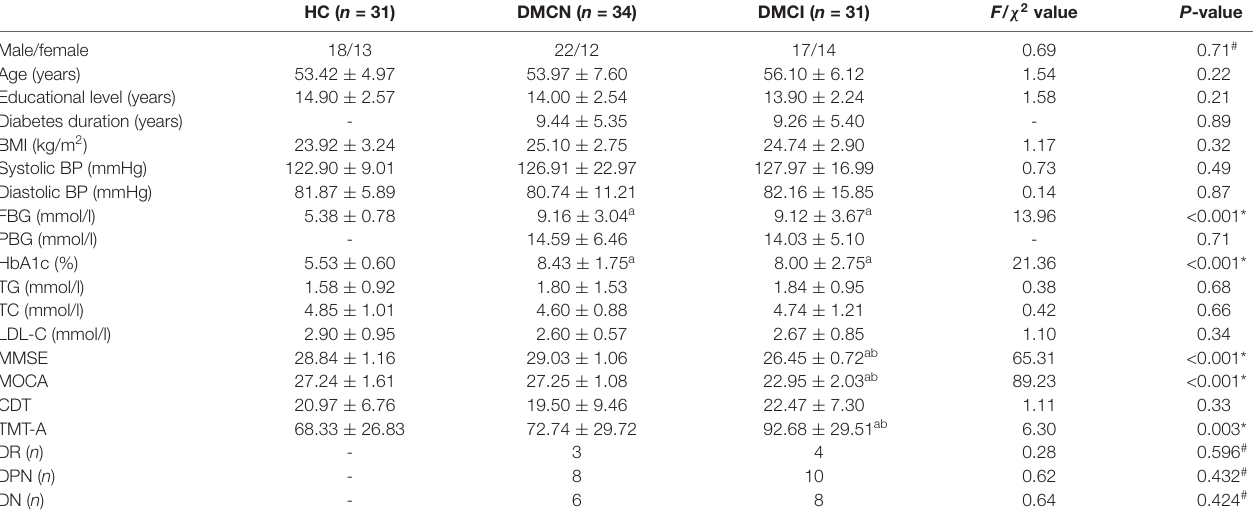
TABLE 1 | Demographic, clinical, and neuropsychological test results.